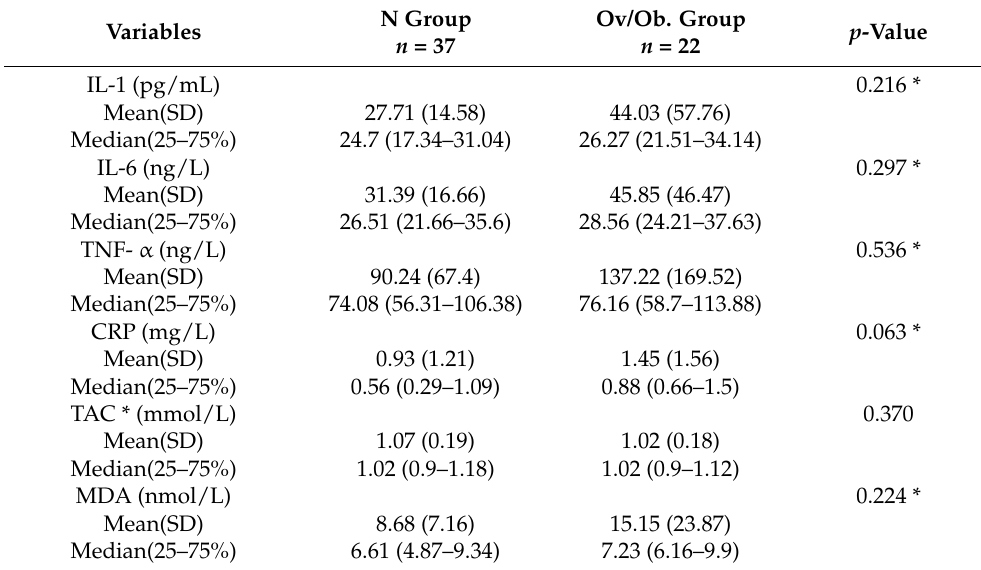
Table 2. Comparison of the inflammatory and antioxidant markers between